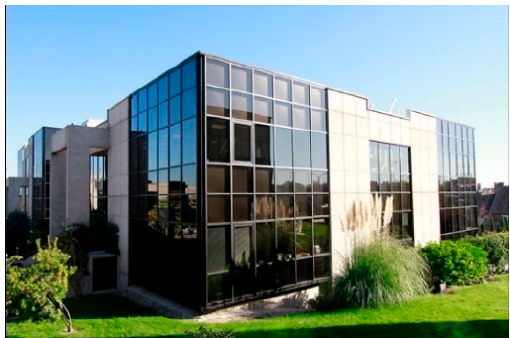
Figure 1. Office reference building under investigation. Latitude: 40.31°N, Longitude: 3.38°W. Location: Madrid, Spain.